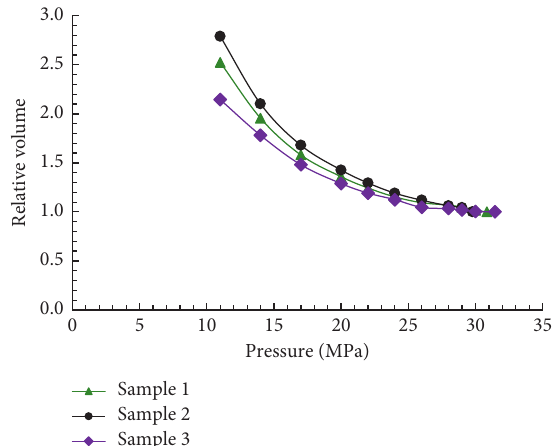
Figure 2: P-V diagram of condensate gas with different CO content.